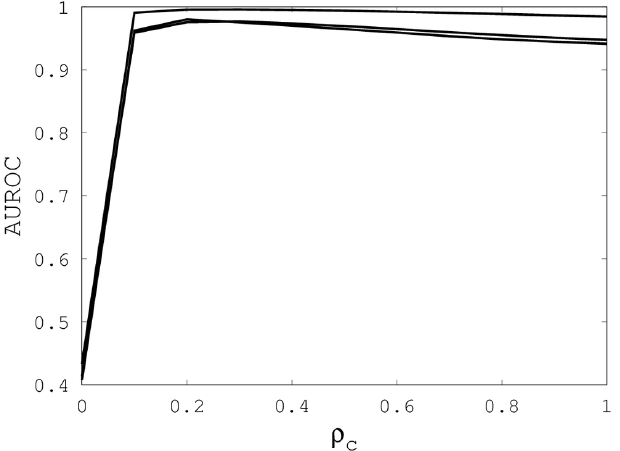
Figure 3. The best AUROC over all ( κ, ρ with one of the random sub-groups of the Proteus300